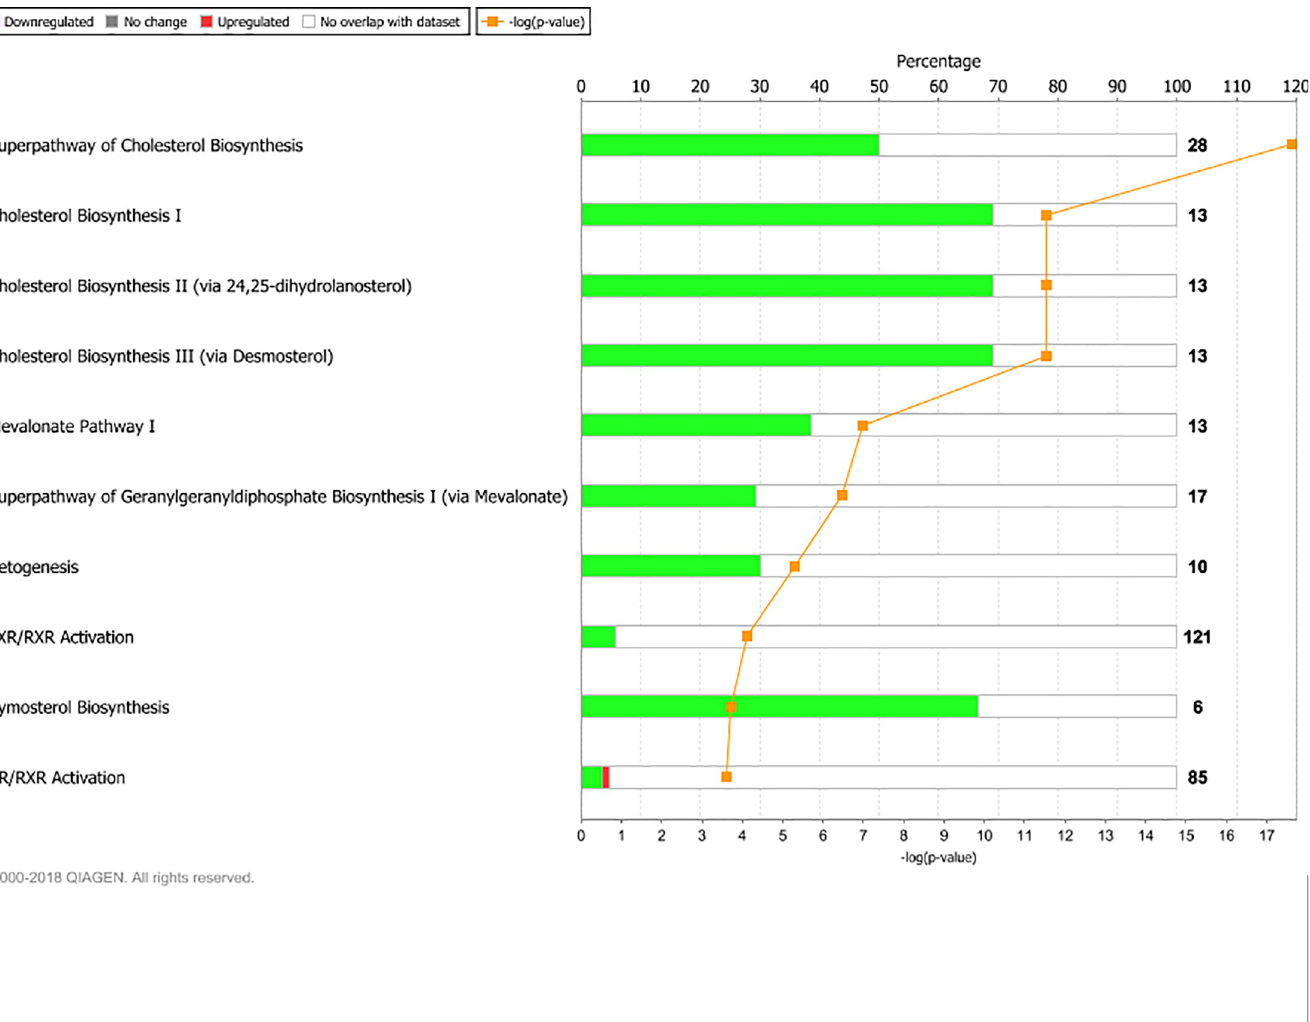
Fig 1. Main pathways affected by differently expressed genes between Low-Protein, High-Energy and Low-Protein, Low-Energy treated heifers at month seven of pregnancy. Main affected pathways between heifers fed Low-Protein, High-Energy (LPHE) or Low-Protein, Low-Energy (LPLE) diets until pregnancy when comparing them at month 7 of gestation. Red bars indicate percent upregulated, and green bars indicate percent downregulated genes pertaining to the pathway in LPHE versus LPLE heifers. Number to the right of bars display total number of genes pertaining to each pathway. Orange squares indicate the negative logarithm of p-value of observation (-log p-value = 1.3 equals p-value = 0.05). (Reprinted from IPA under a CC BY license, with permission from Qiagen Bioinformatics, original copyright 2018).